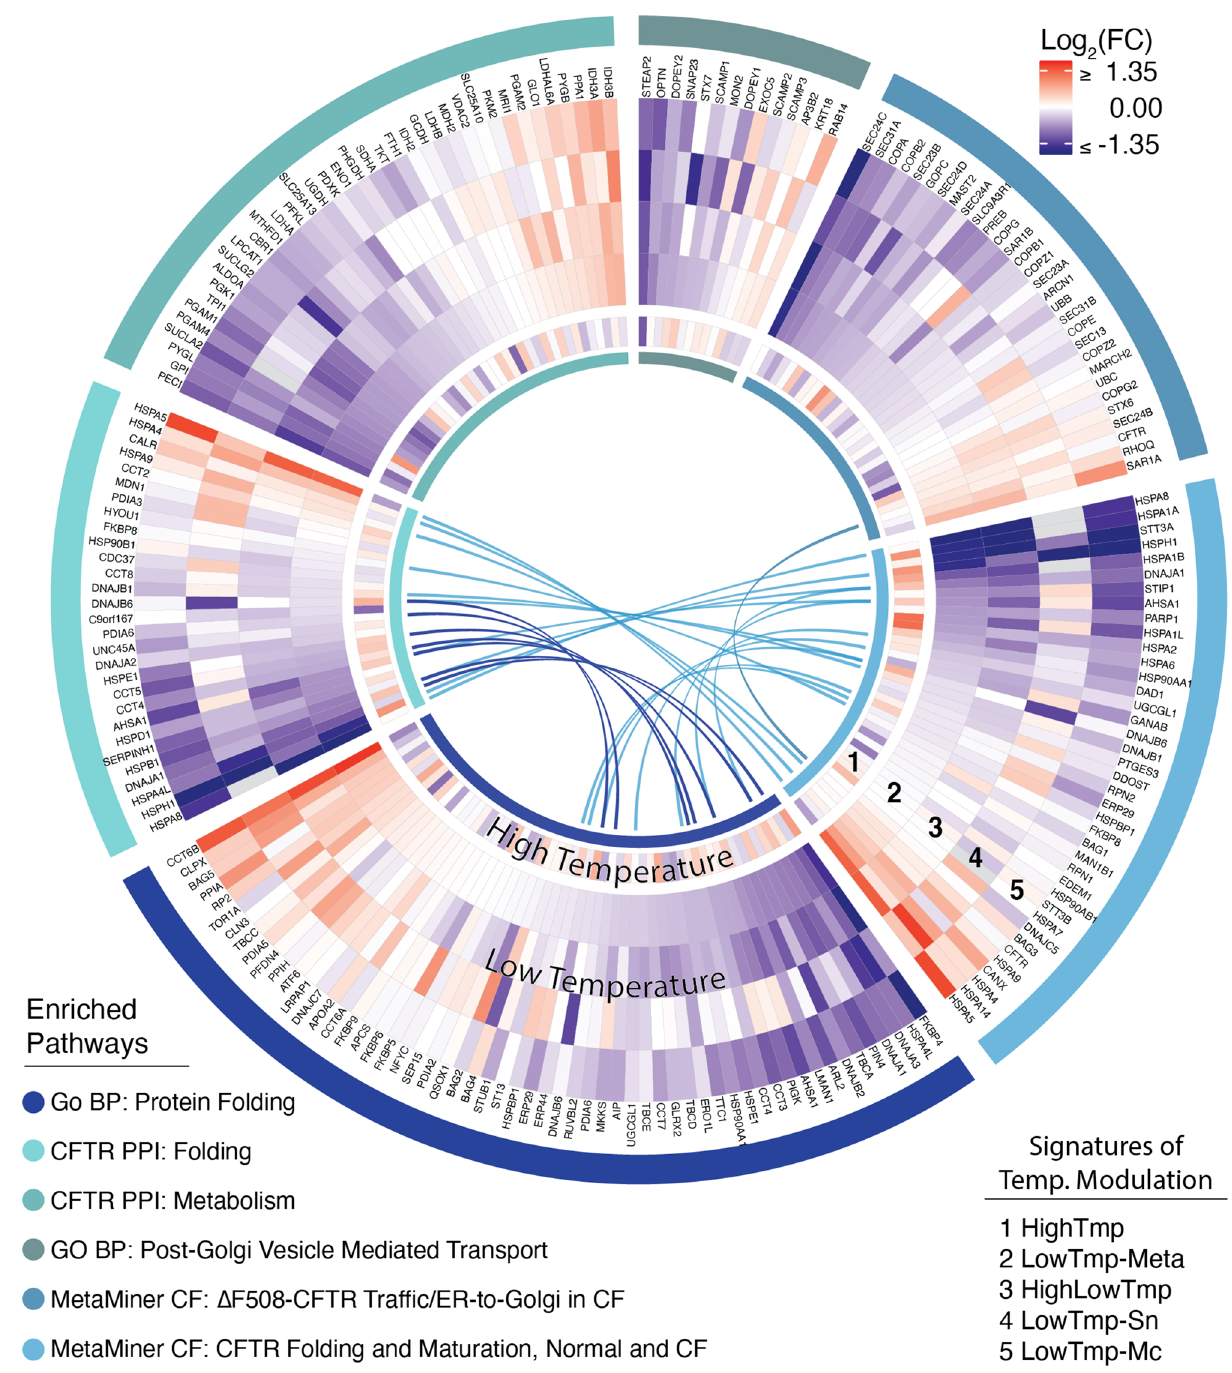
Figure 4. Temperature-induced modulation of selected CFTR-relevant gene sets. “Columns” emanating from the center represent genes, which are grouped according to pathways, as indicated by the colors in the outermost circle. Concentric circles represent individual signatures and/or the core LowTmp-Meta signature, as indicated by the numbered legend. Arcs in the center connect genes that are shared between